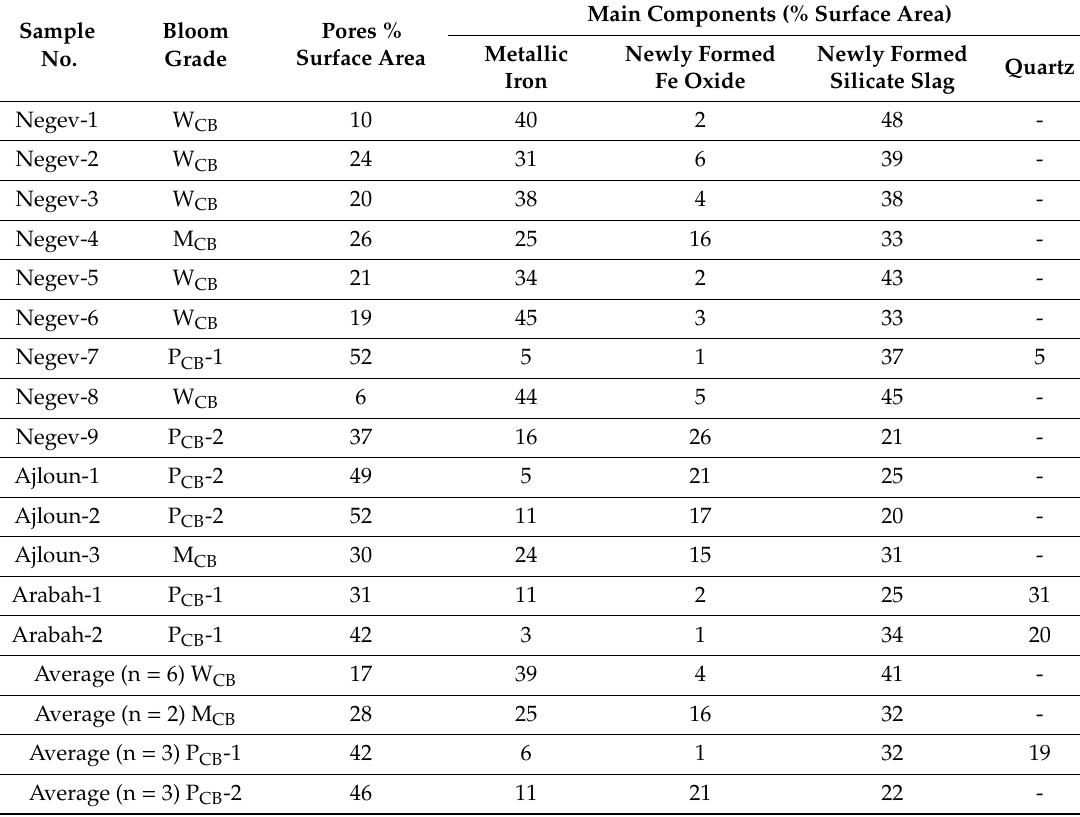
Table 4. Results of image analysis of polished sections of blooms: Quantified percent surface area of porosity and main phase